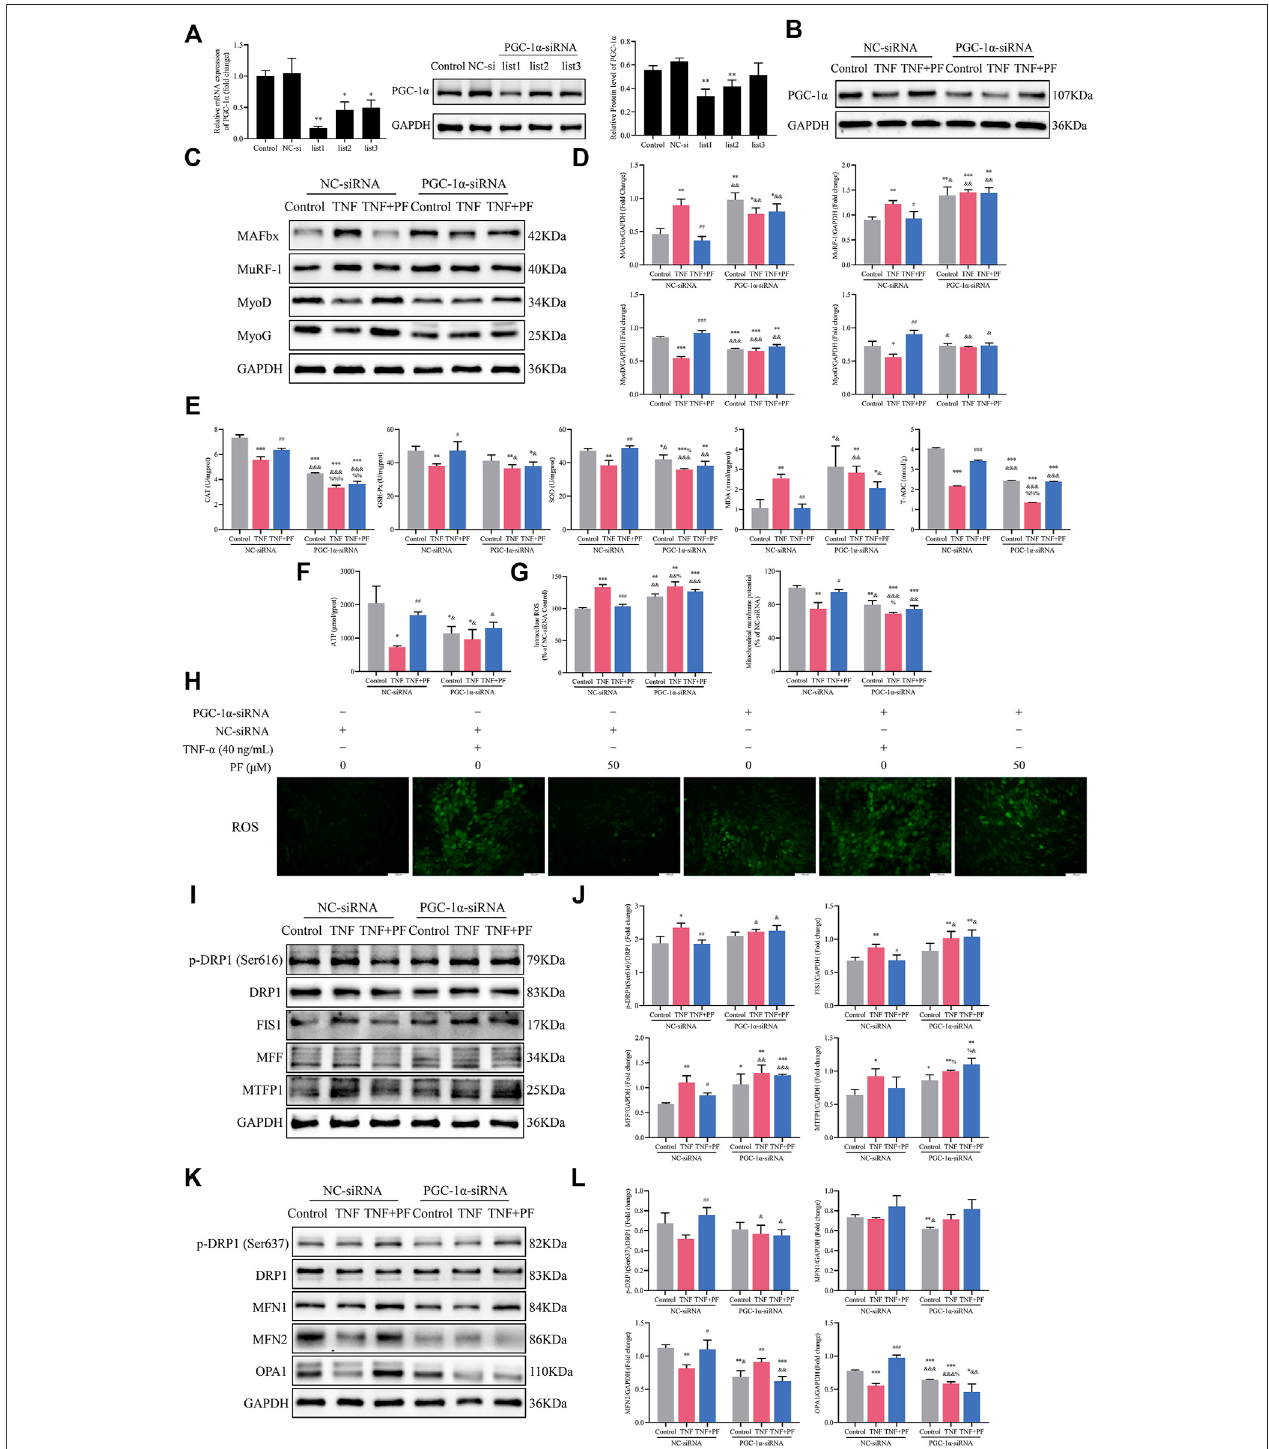
FIGURE8| PGC-1 α mightbeimportantinmediatingtheeffectsofPFonTNF- α -treatedC2C12cells. (A) TheproteinandmRNAexpressionofPGC-1 α wasdetectedin C2C12 myoblasts transfected with PGC-1 α -targeted siRNA (PGC-1 α -siRNA) and nonspeci fi c control siRNA (NC-siRNA). (B) Representative immunoblots of PGC-1 α expressioninNC-siRNA-andPGC-1 α -siRNA-transfectedC2C12cellstreatedwithTNF(TNF- α 40 ng/ml)andTNF+PF(PF50 μ M). (C) Representativewesternblotsusing antibodiesagainstMAFbx,MuRF-1,MyoD,MyoGandGAPDH. (D) Westernblotanalysis. (E) TheactivitiesofCAT,GSH-Px,SOD,MDA,andT-AOCinC2C12cellsin different groups. (F) The expression of ATP in different groups. (G) The expression of intracellular ROS generation and Δψ m in different groups. (H) Intracellular ROS were